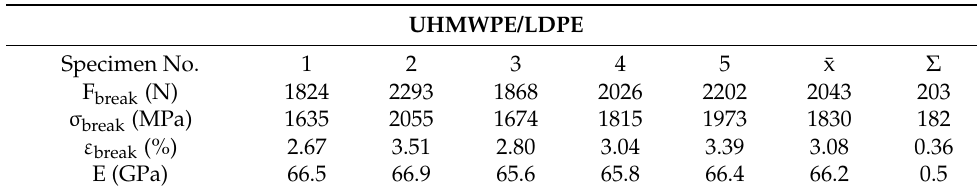
Figure 6. Typical tensile failure of the composite. Table 5. Tensile results of the composite.